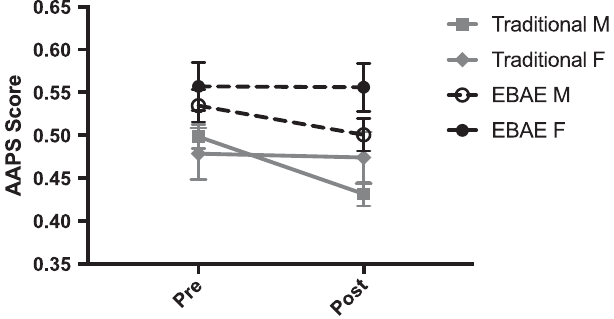
FIG. 3. Raw normalized data (i.e., without controlling for prescores) show the first semester average AAPS scores by gender and method of instruction. Average male scores ( M ) are indicated by squares for traditional male students (total number n ¼ 197 ) and open circles for EBAE male students ( n ¼ 118 ). Average female scores ( F ) are indicated by diamonds for tradi- tional female students ( n ¼ 42 ) and closed circles for EBAE female students ( n ¼ 61 ). Error bars represent standard